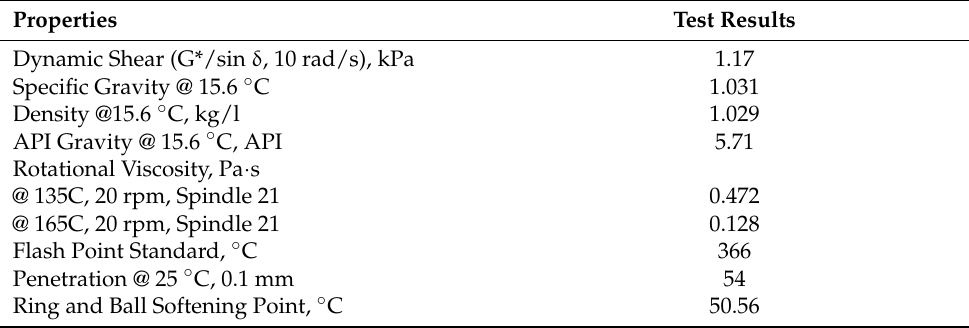
Table 4. Properties of asphalt binder PG 67-22 (provided by material